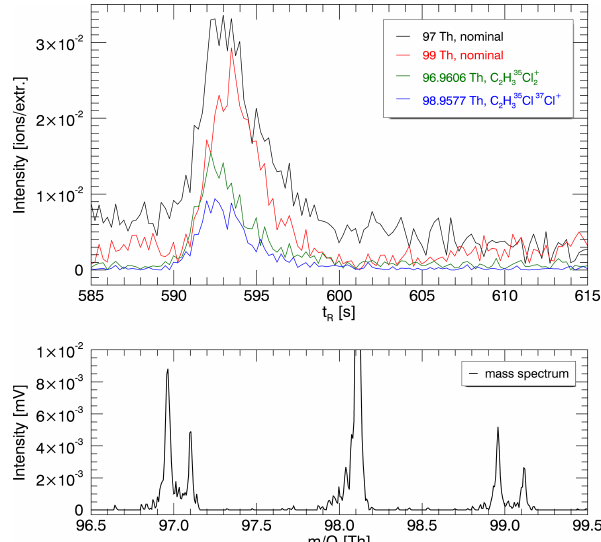
Figure 7. Upper graph: chromatographic signal of methyl chloroform (CH 3 CCl 3 ) on ion masses 97 and 99Th, nominal mass intensities shown in black and red, accurate mass intensities shown in green and blue. Lower graph: mass spectrum excerpt at the chromatographic peak apex. A coeluting substance with matching retention time and nominal masses 97 and 99Th leads to a systematic error in mixing ration determination if the nominal mass intensity is used for substance quantification. Unit conversions, y axis of lower to upper graph: see Fig.